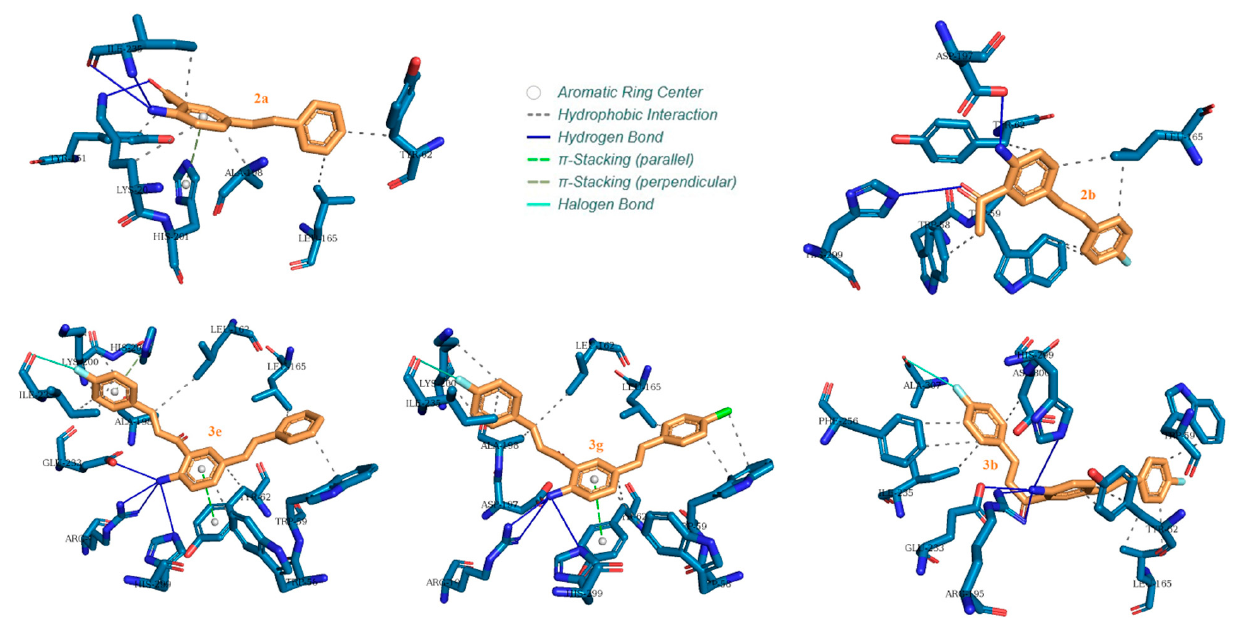
Figure 5. The interaction between the most ( 2a , 3e and 3g ) and the least ( 2b and 3b ) active compounds against α -gluco- sidase.